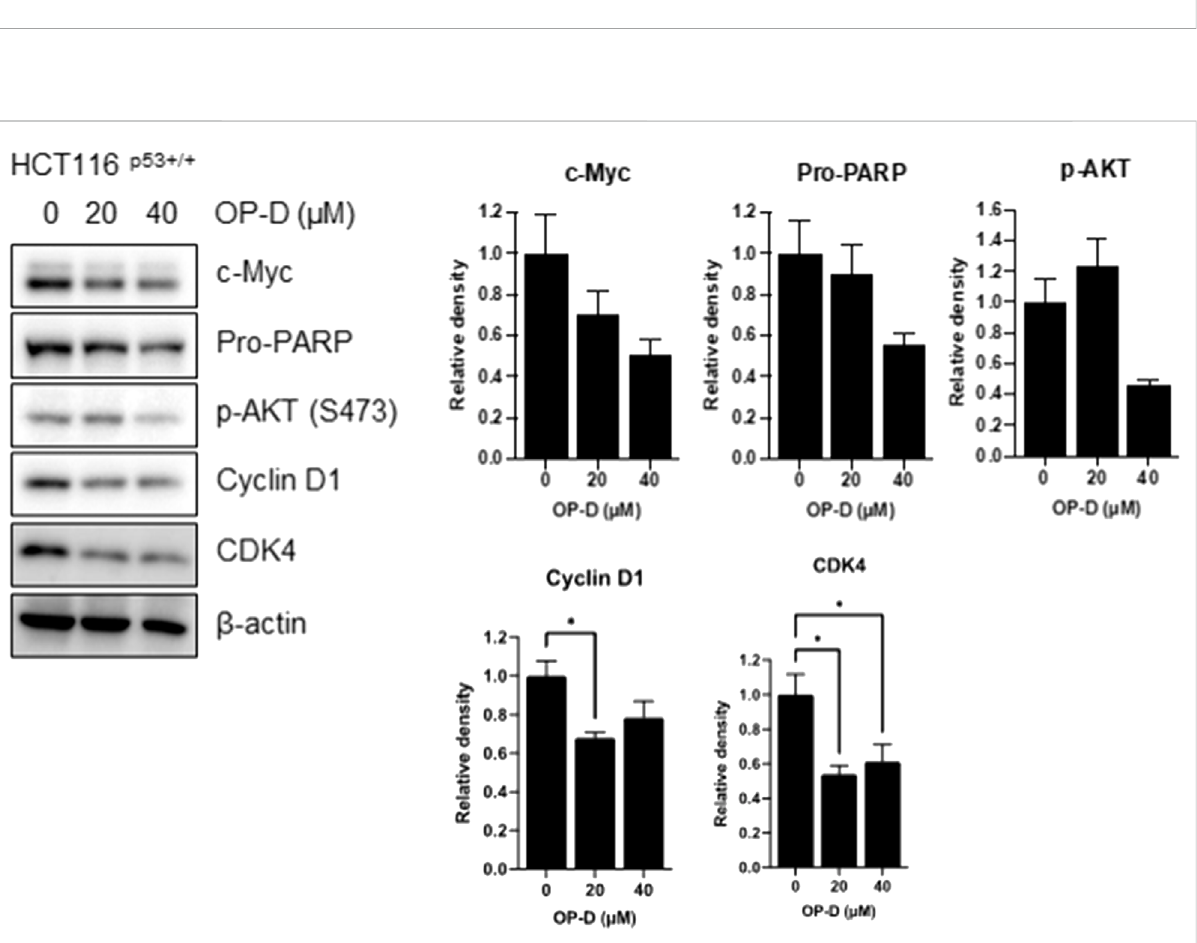
FIGURE 7 OP-D inhibited c-Myc expression in HCT116 p53+/+ cells. HCT116 p53+/+ cells were treated with OP-D (0, 20, or 40 μ M) for 24 h. Cell lysates were performed for c-Myc, Pro-PARP, p-AKT, cyclin D1, CDK4, and β -actin by Western blotting. Data represent means ± SD. * p < 0.05 versus untreated